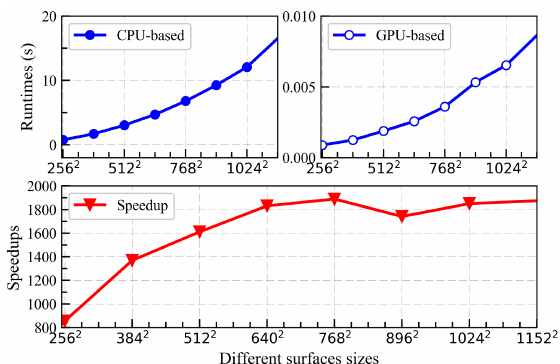
Figure 14. Runtime and speedup for the GPU ‐ based SDCSM program for different surface sizes.